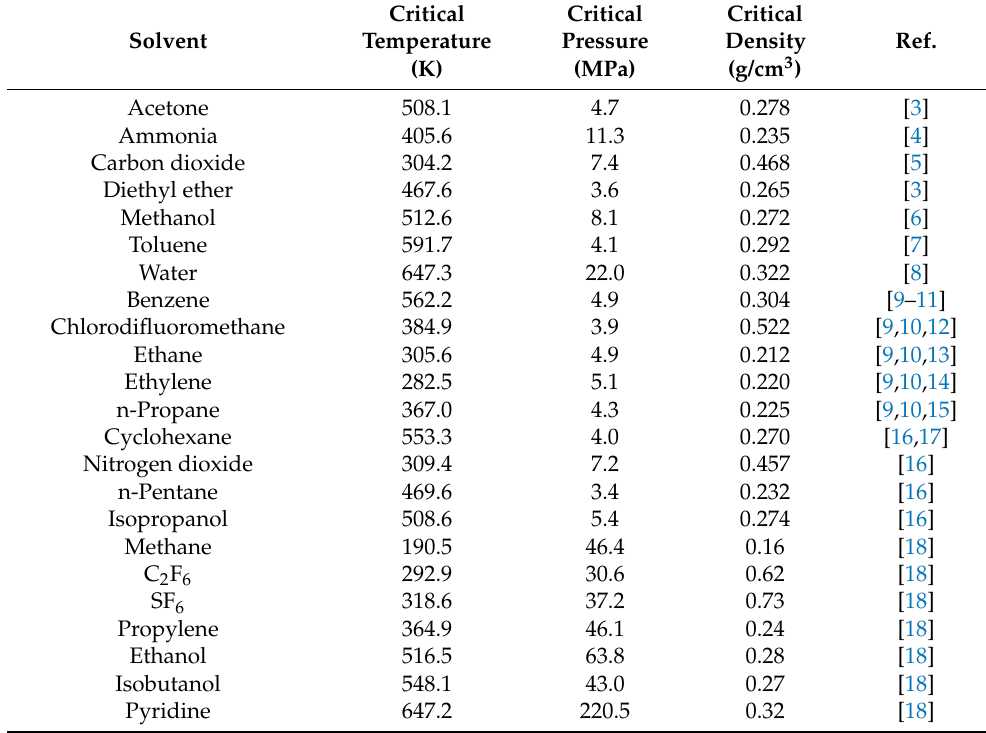
Table 2. Critical parameters of exemplary